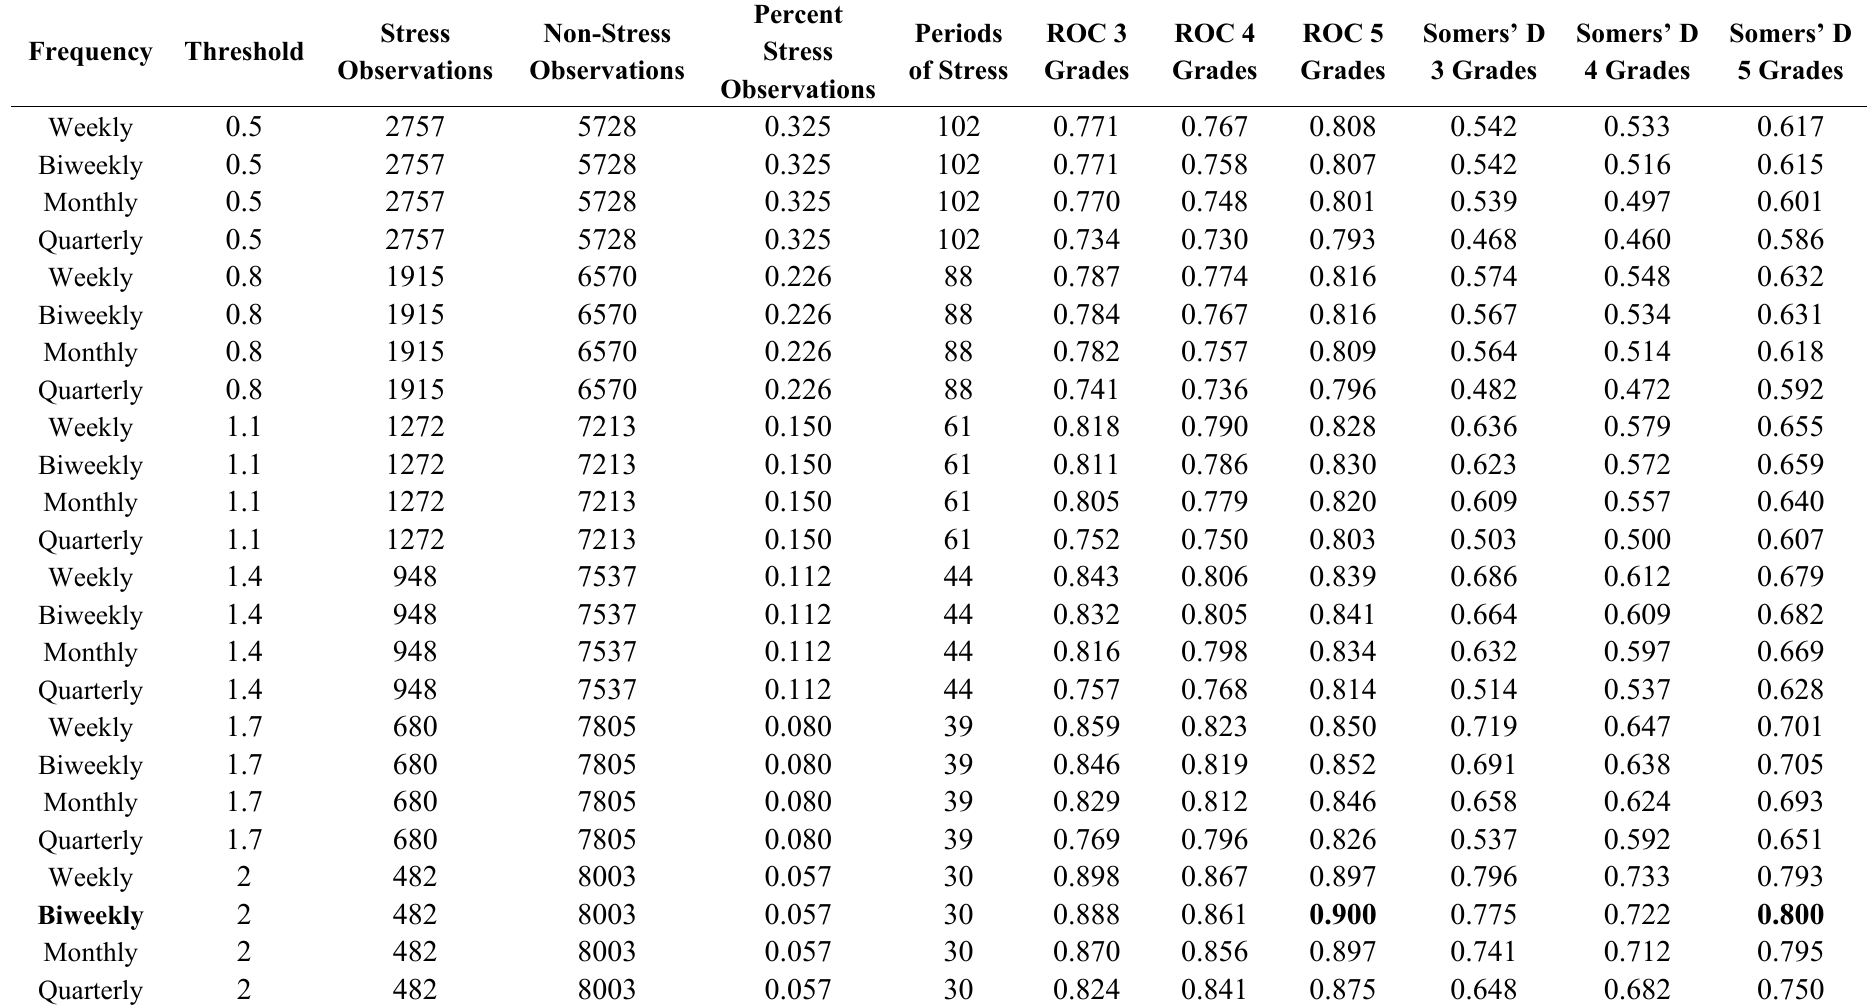
Table 5. Systemic stress episodes and non-parametric testing of rating